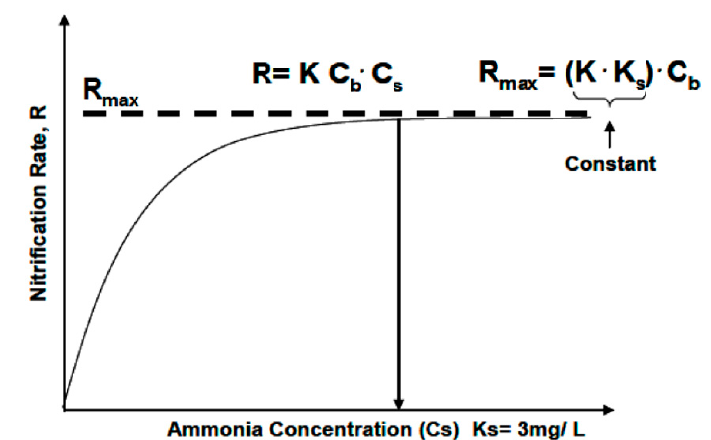
Figure 2. Relationship between peak nitrification rate (R) and nitrifiers concentrations (Cb) [32].